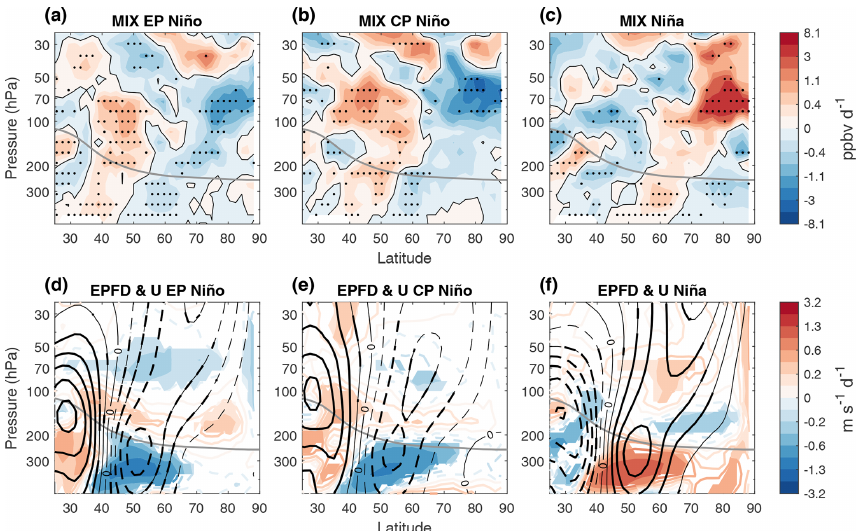
Figure 6. Latitude–pressure cross sections of the composite of anomalies in the November–March (NDJFM) zonal-mean (EP El Niño) and January–March (JFM) (CP El Niño and La Niña) (a–c) ozone tendency related to mixing and (d–f) EPFD (colors) and zonal wind (black contours) for (from left to right) EP El Niño, CP El Niño and La Niña events. Contours in bottom panels are drawn every 0.5ms − 1 for zonal winds. Solid (dashed) contours denote positive (negative) anomalies. The NDJFM or JFM mean tropopause is indicated by the thick grey line. Color shading (bottom panels) and black dots (upper panels) denote statistically significant anomalies at the 95% confidence level; thick contours denote statistically significant anomalies for zonal